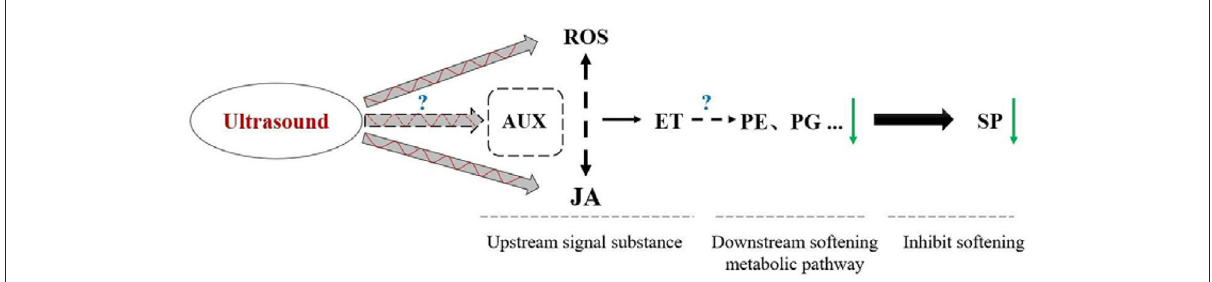
FIGURE10 Hypothetical model explaining the physiological mechanisms inhibiting postharvest softening in strawberry treated with ultrasound. “ + ” presented promotion; “–” presented suppression; solid arrow presented direct regulation; and dotted arrow presented unclear regulation